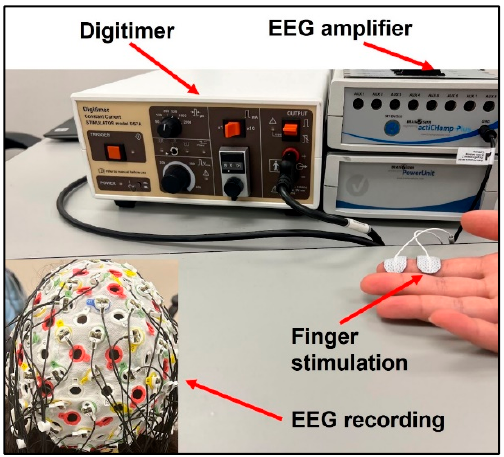
Figure 1. Experimental Setup.